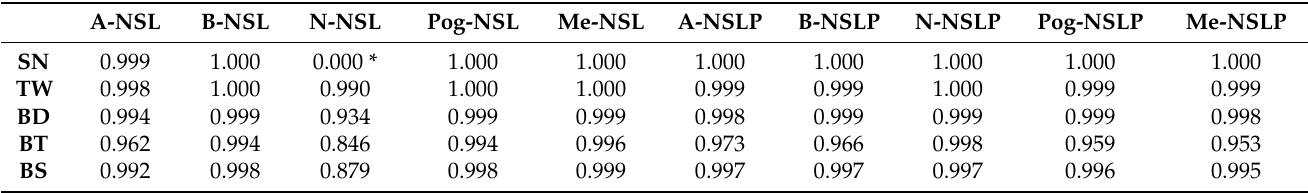
Table 4. Intra-observer reliability levels of all the studied superimposition methods (SN, TW, BD, BT, and BS), assessed as the ICCs for 10 variables.